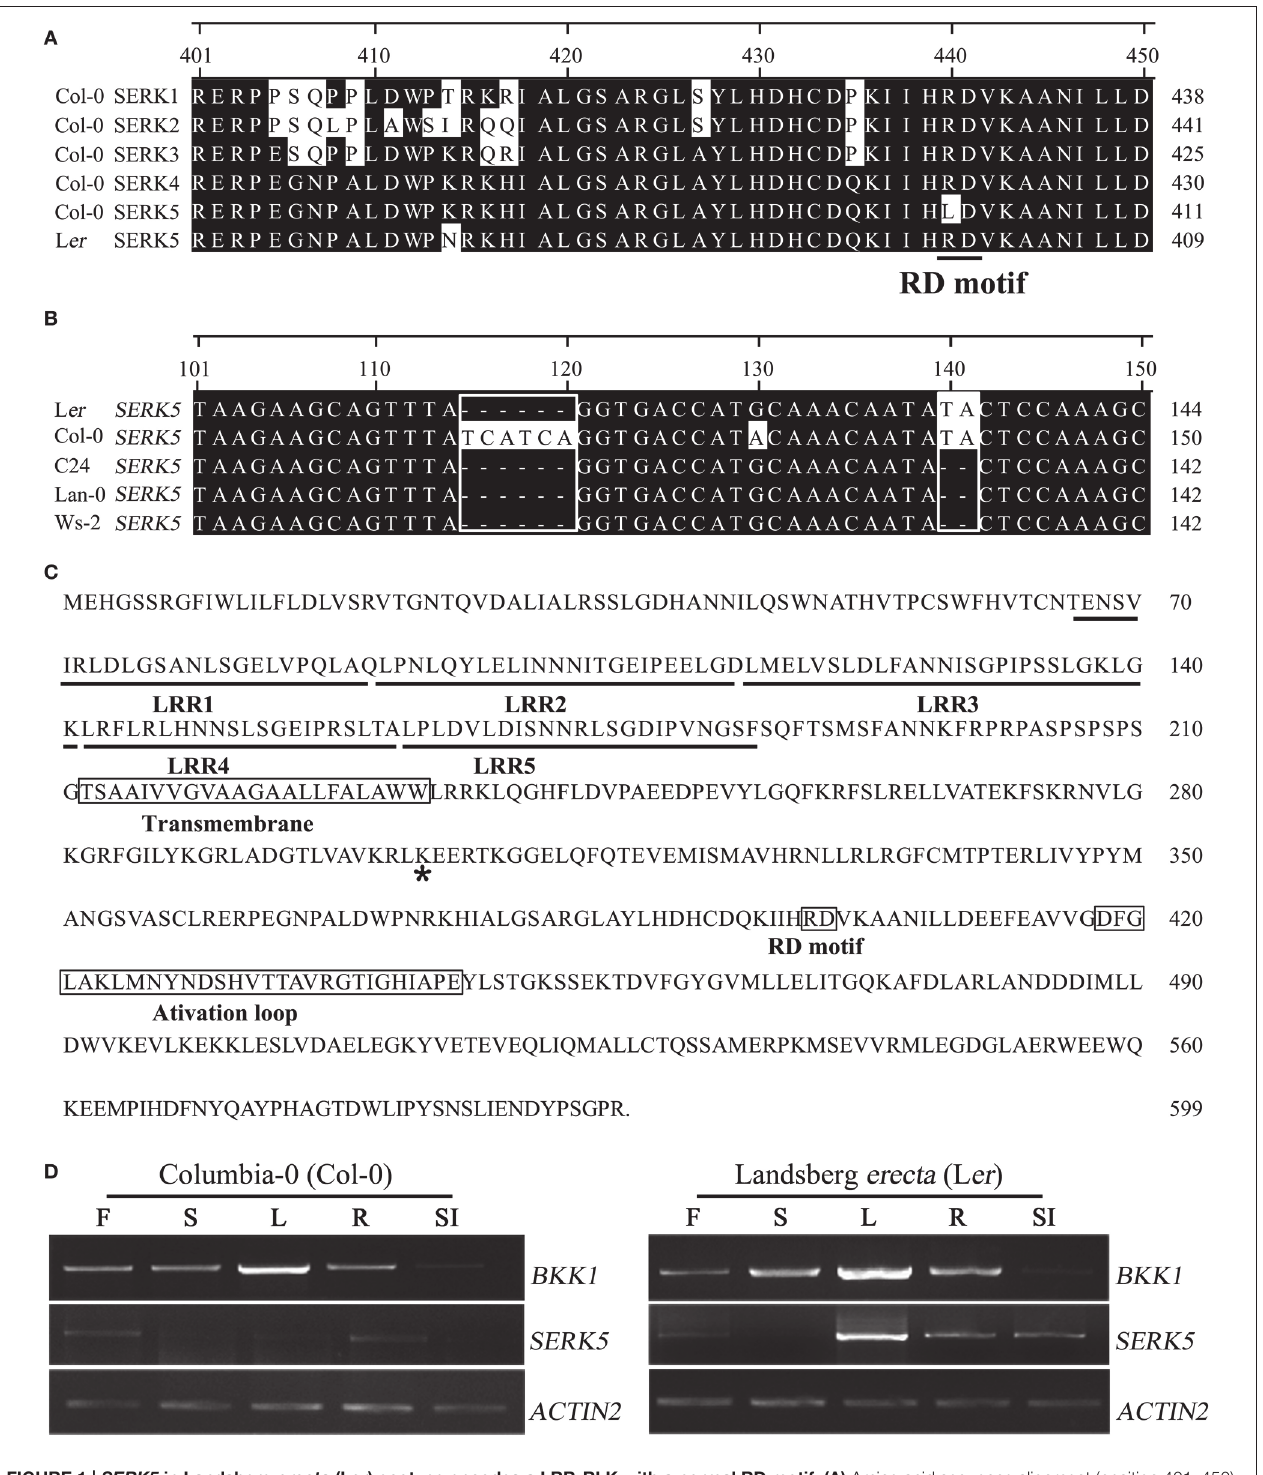
Frontiers in Plant Science | www.frontiersin.org